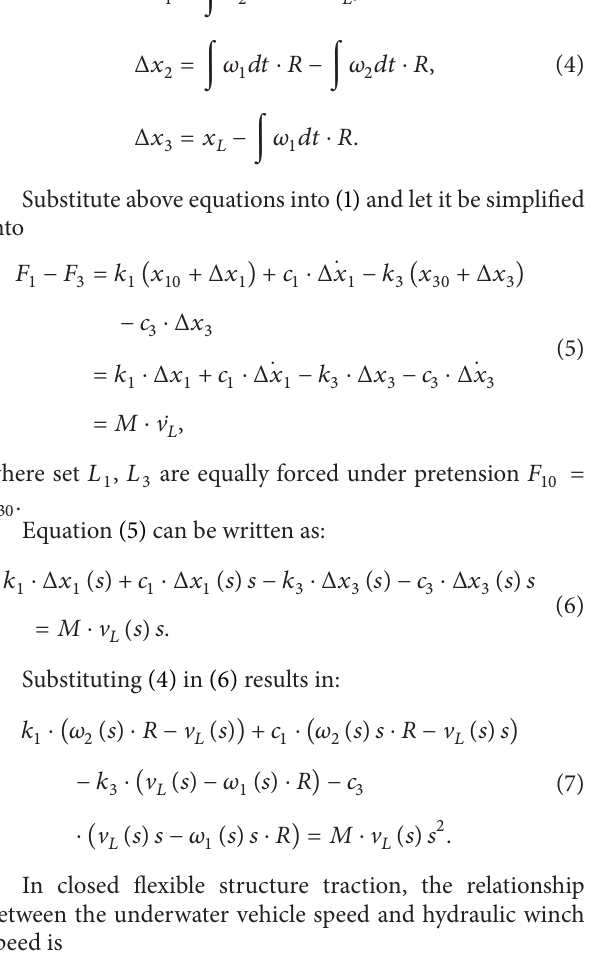
𝑅 represents radium, 𝑘 2 is the guide wheel rotational speed, 𝐿 𝑘 𝑐 2 , and 3 and 3 are the elasticity and viciousness of